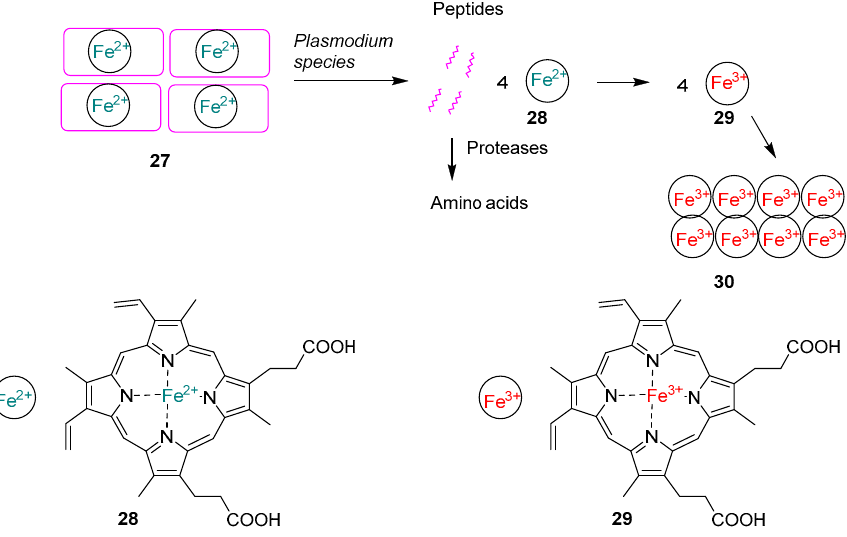
Figure 10. Digestion of hemoglobin ( 27 ) to give ferroprotoporphyrin ( 28 ), which spontaneously oxidizes to ferriprotoporphyrin IX ( 29 ). Precipitation of hemozoin ( 30 ) prevents the toxic effects of 29 [76,77].